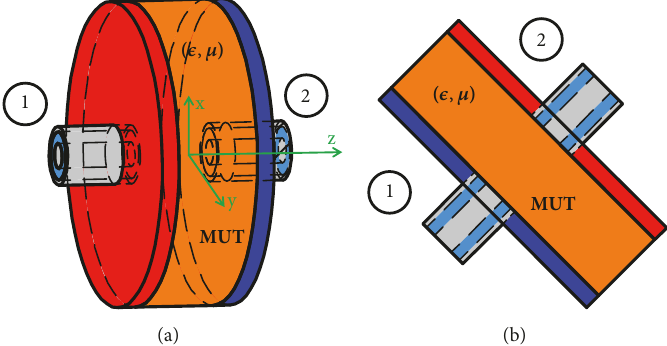
Figure 2: Schematic of the two-port coaxial holder for dielectric measurement, showing the material under test (MUT): (a) 3D schematic view; (b) longitudinal cut (revolution symmetry with respect to